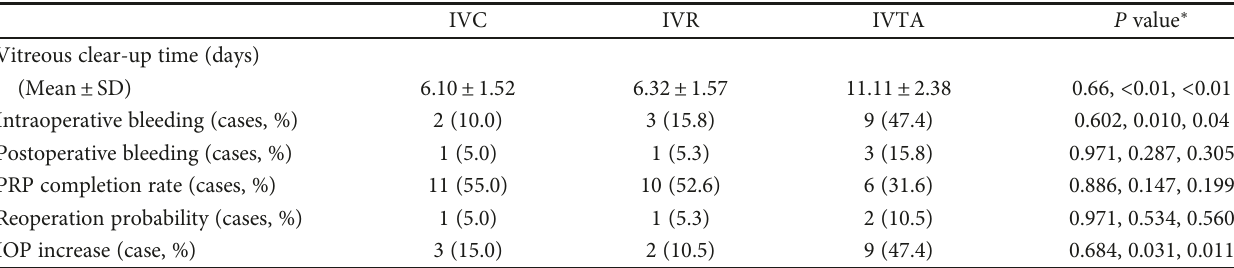
Figure 3: Comparison of outcomes of IVC, IVR, and IVTA groups at 6m. There were no signi fi cant di ff erences in operation time, incidence of iatrogenic retinal breaks, endodiathermy rate, and silicone oil tamponade between IVC and IVR groups. However, each of these two groups showed signi fi cant di ff erence with the IVTA group. Table 4: Secondary outcomes and